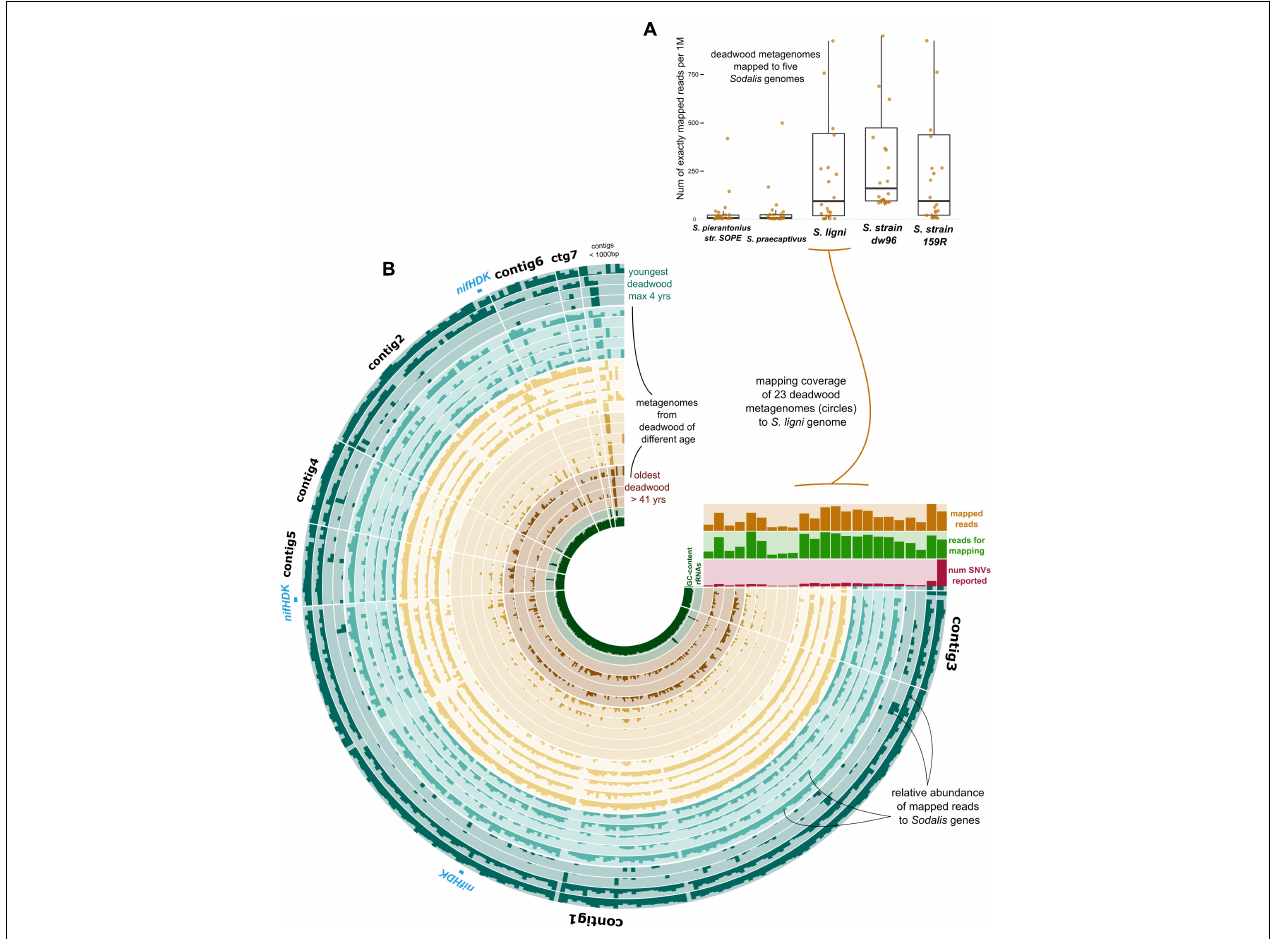
FIGURE 4 | Deadwood metagenome mapping against the genome of S. ligni . (A) Boxplots show deadwood mapping count for wood-associated strains and S. pierantonius strain SOPE and S. praecaptivus . (B) The anvi’o plot with circles representing metagenome samples, the color coding of circles follows grouping of samples based on the length of deadwood decomposition. Dark bar plots within circles represent the relative abundance of reads mapped to S. ligni genes. Contigs were ordered based on the Euclidean distance and Ward